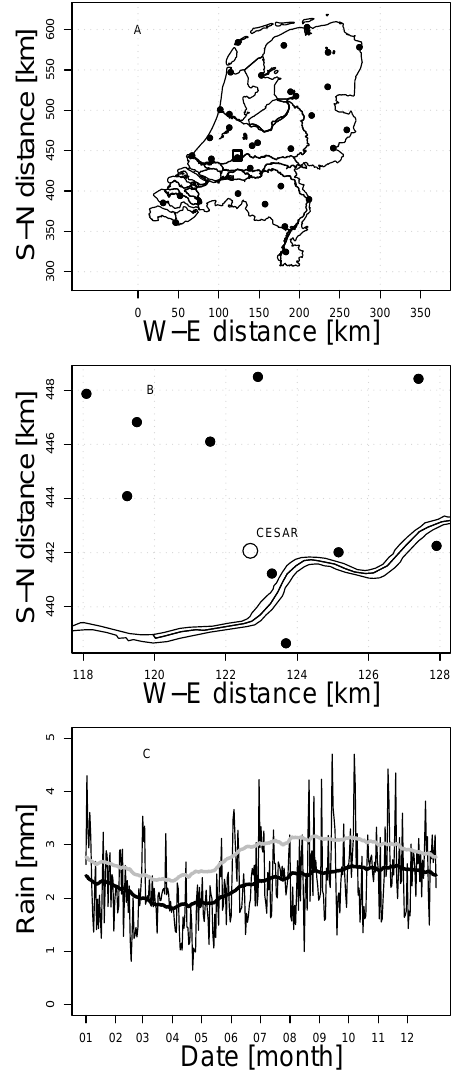
Fig. 1. (A) station locations of the 33 KNMI measurement stations. The square near the centre of The Netherlands is shown in (B) and is a detail of the 10 selected gauges of the dense gauge network. (C) The 30-year mean rainfall in The Netherlands, where the thin black line is the average rainfall for each day, the thick black line the 90-day moving average and the thick grey line the 90-day moving average for rainfall events only (i.e. with dry days excluded).